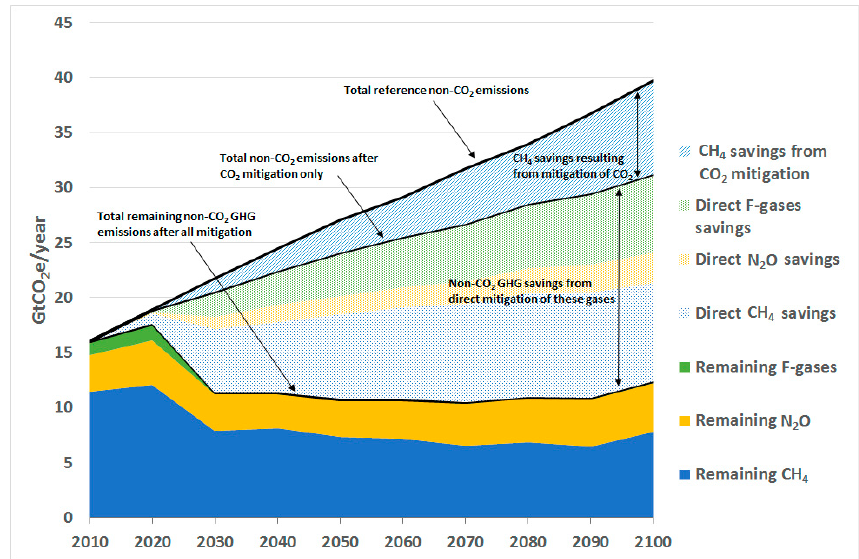
Figure 4. Non-CO 2 GHG direct emissions savings (relative to baseline) as a result of applying a CO 2 e price equal to the fossil fuel and industry CO 2 price, 2 °C scenario with action delayed to 2020. Notes: From 2030 onwards, F-gas emissions are around 0.1 GtCO 2 e per year.